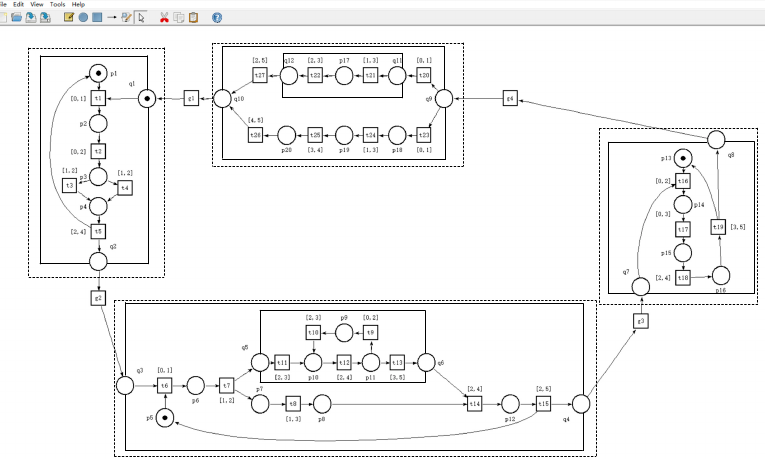
Figure 7. Σ (cid:2870) = {𝑁 (cid:2870) ,𝐹 (cid:2870) ,𝐺 (cid:2870) ,𝑀 (cid:2870) } obtained using the TQ-type internal subnet reduction rule.